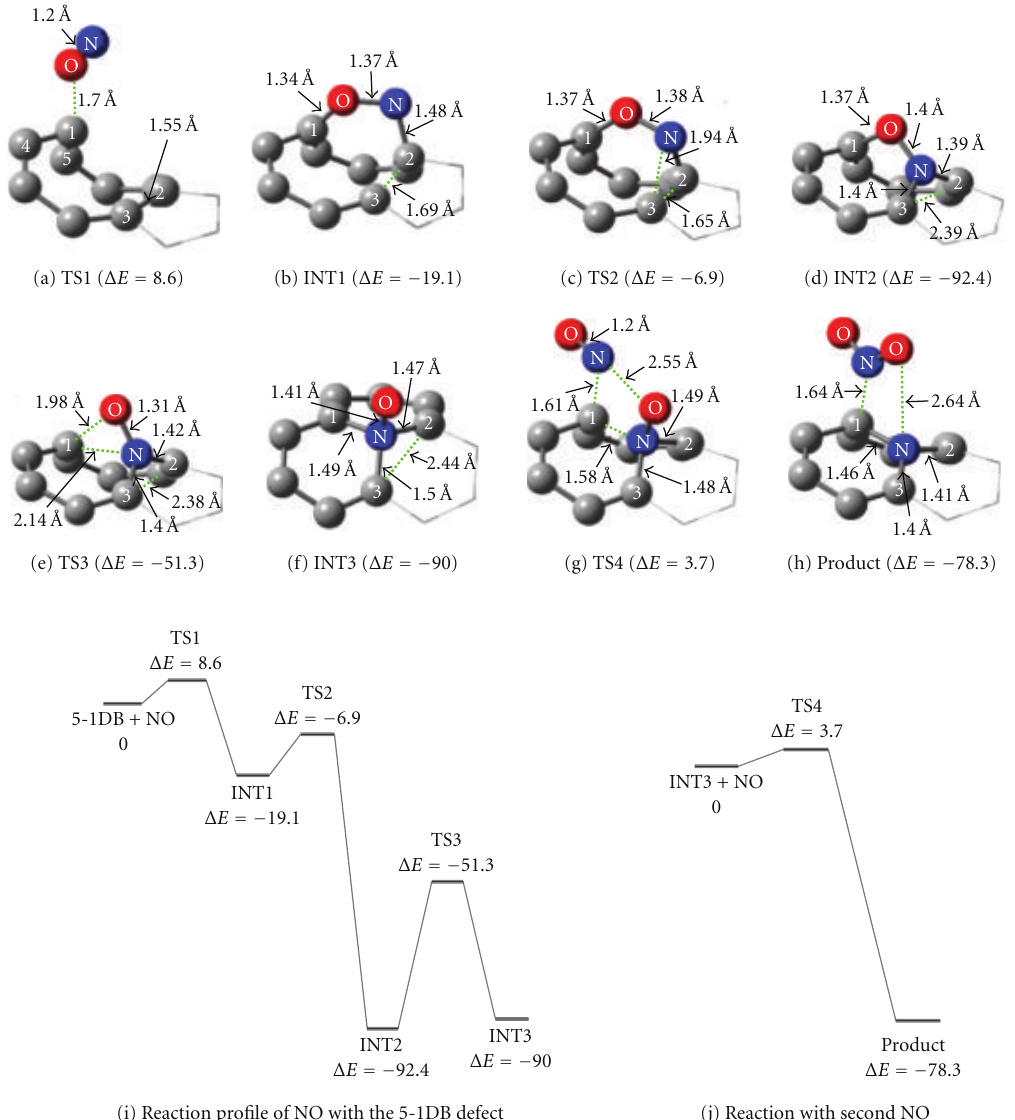
Figure 7: Optimized geometries (with distances in ˚A) and energy profiles (with energies in kcal/mol) for the reaction of the defected SWCNT with NO [81]. Legend: dark grey = carbon, navy blue = nitrogen, red =